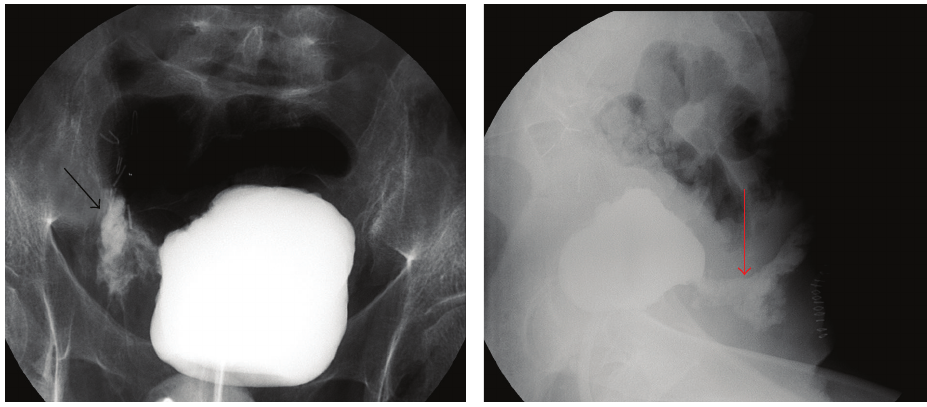
Figure 5: A cystography three weeks postoperatively showed some contrast extravasation into the space of Retzius.